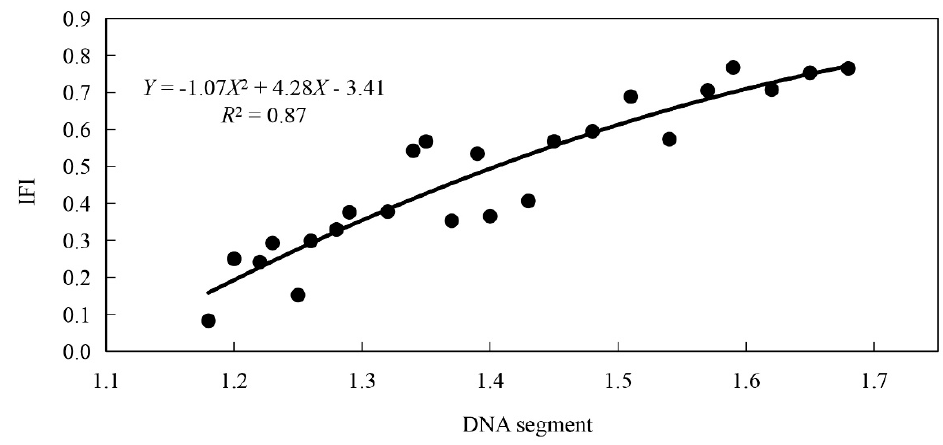
Figure 5. The relationship between the genetic diversity of soil microorganisms and soil fertility.